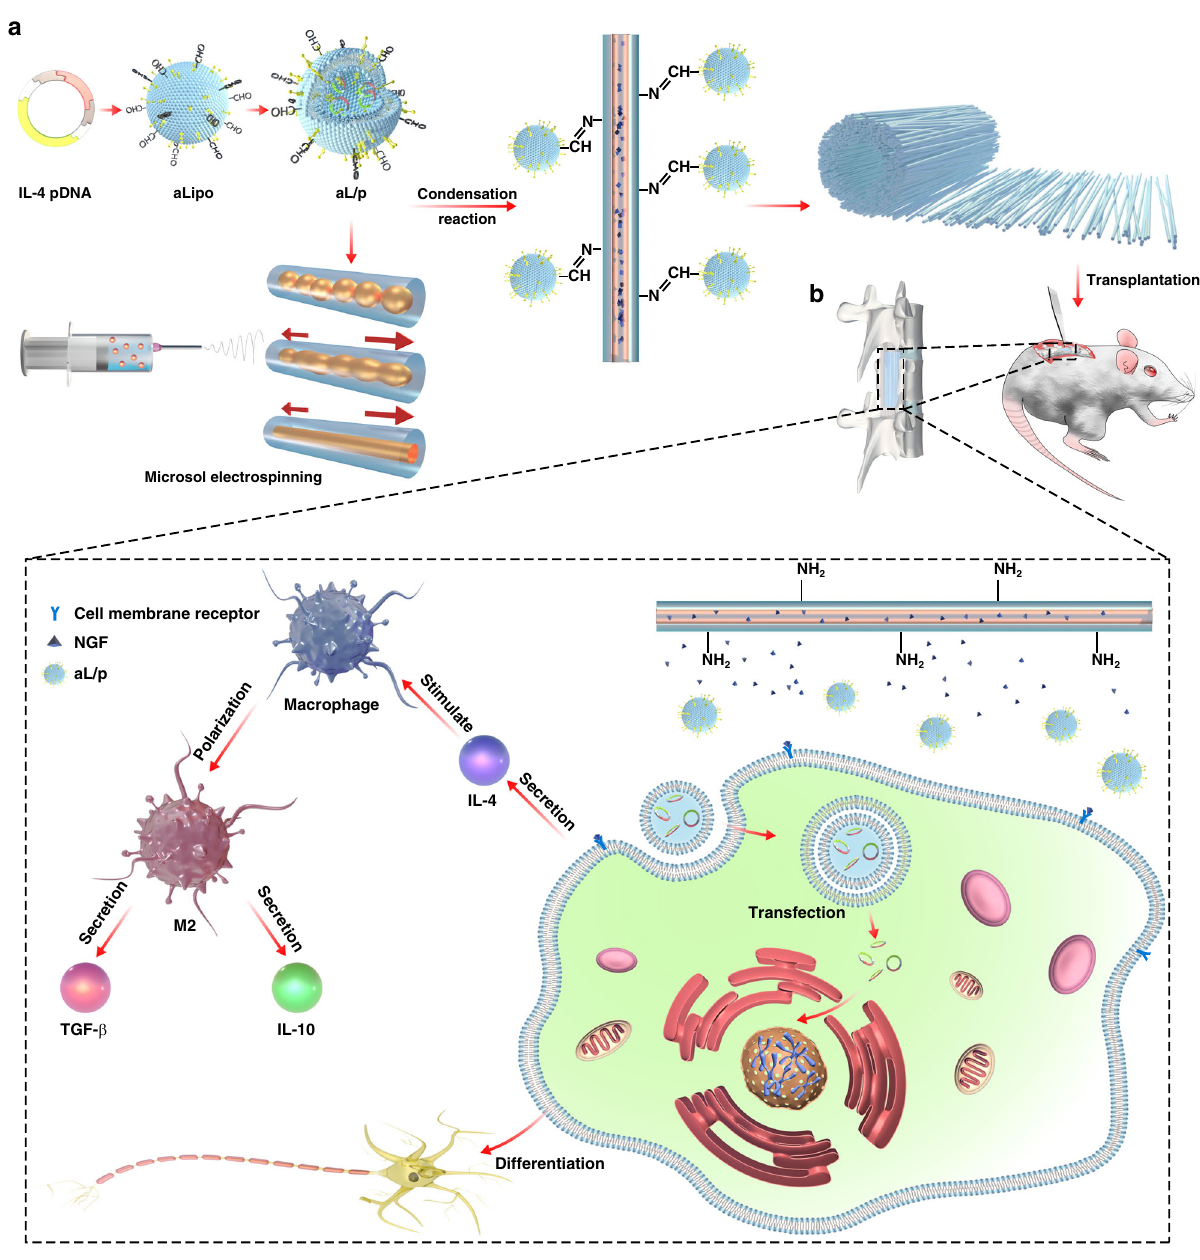
Fig. 1 Construction and effect mechanism of composite fi ber. Scheme illustration of a the construction of bioinspired composite scaffold for the treatment of spinal cord injury along with b its microenvironment-responsive immune regulation and nerve regeneration